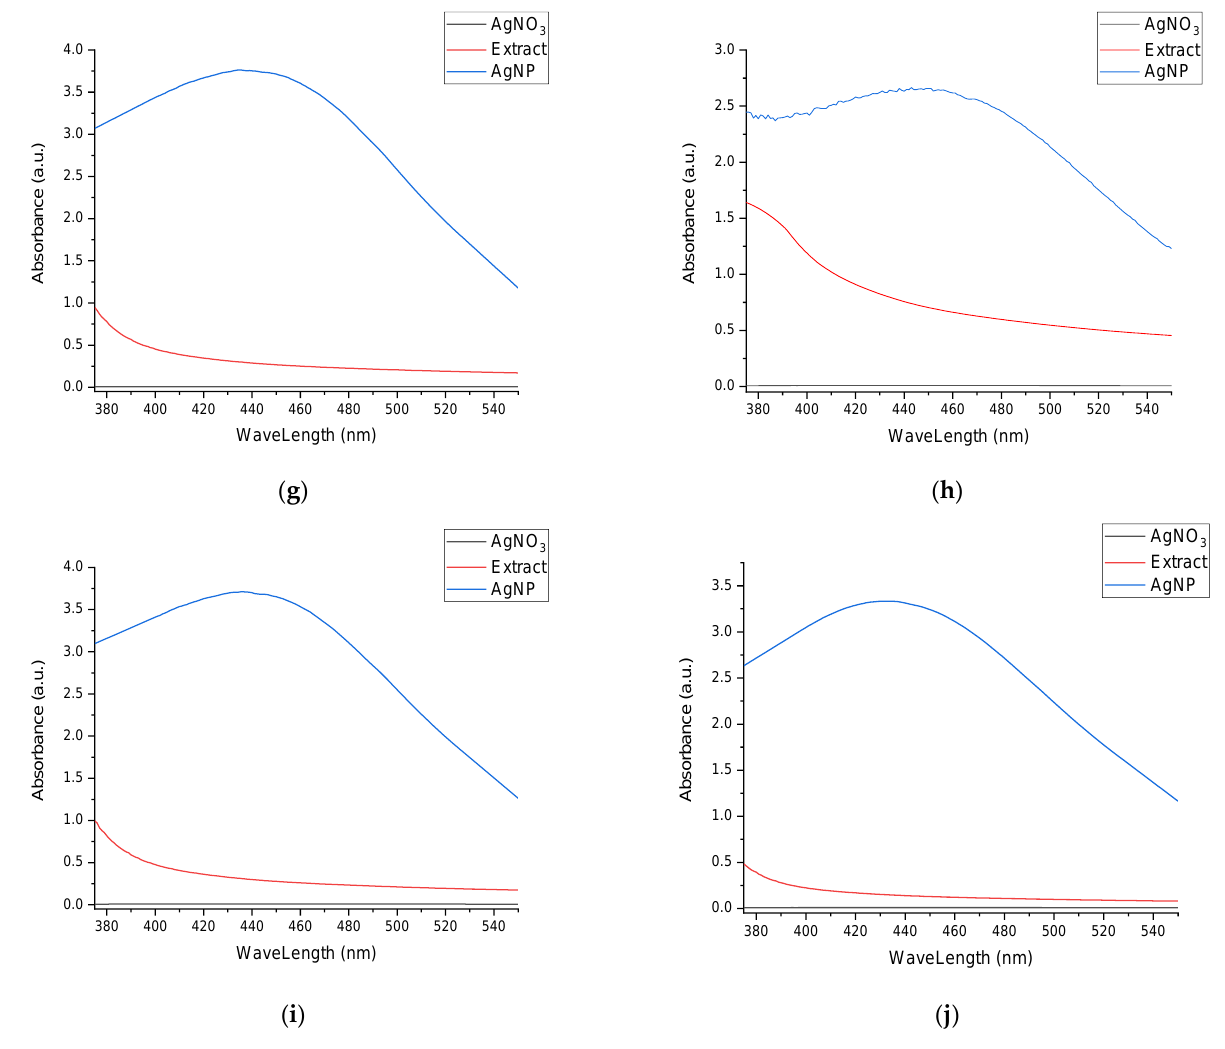
Figure 3. Confirmation of phytosynthesis of silver nanoparticles by the comparison of nanoparticles’ UV-Vis spectra with the corresponding extracts and AgNO 3 solution: ( a ) sample EE5; ( b ) sample EE2.5; ( c ) sample EE2; ( d ) sample EE1.25; ( e ) sample EE1; ( f ) sample EM5; ( g ) sample EM2.5; ( h ) sample EM2; ( i ) sample EM1.25; ( j ) sample EM1. To determine the sizes of the nanoparticles using the DLS technique, five/ten determinations were made for each sample (depending on the complexity of the sample) directly on the nanoparticle solution, without any dilution or treatment. The results are presented in Figure 4 and Table 4, respectively.